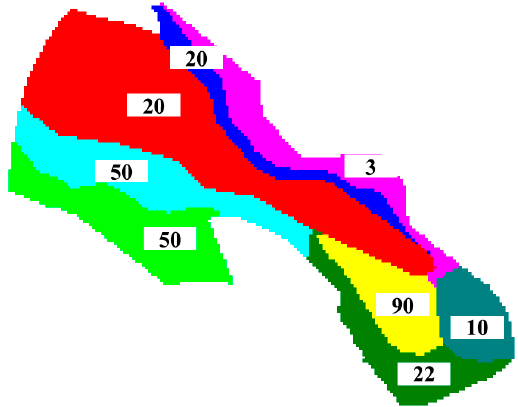
Figure 3. The sub-zon es and values of hydraulic conductivities.